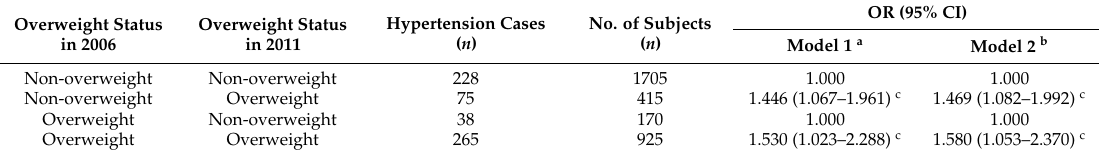
Table 3. The incidence of hypertension stratified by overweight status in 2006 and 2011. Overweight Status Overweight Status in 2006 in 2011 Non-overweight